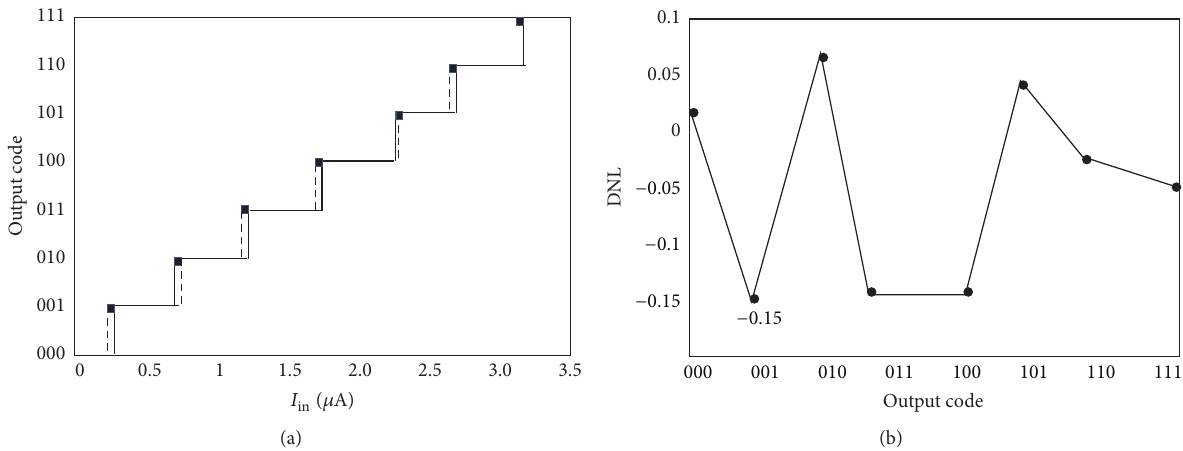
Figure 10: (a) CM flash ADC transfer characteristics and (b) DNL versus output